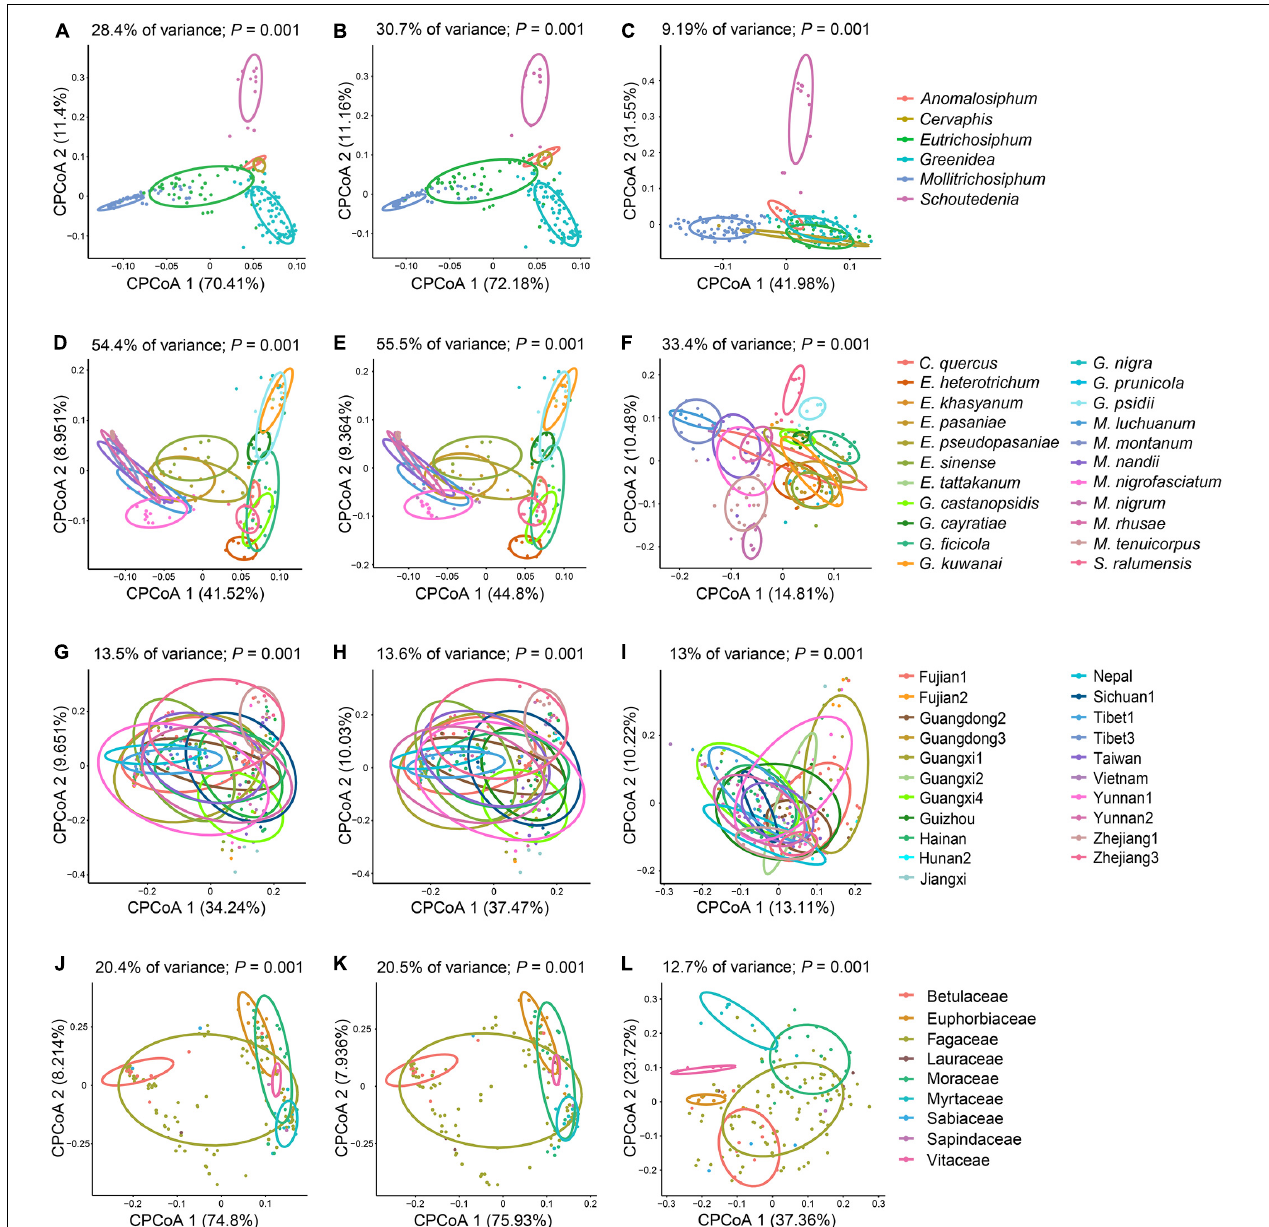
FIGURE 4 | Constrained principal coordinate analysis (cPCoA) plots of Bray–Curtis distances of bacterial (A,D,G,J) , symbiont (B,E,H,K) , and secondary symbiont (C,F,I,L) communities ( n ≥ 3). Plots are structured by aphid genus (A–C) , aphid species (D–F) , geographic region (G–I) , and host plant (J–L)